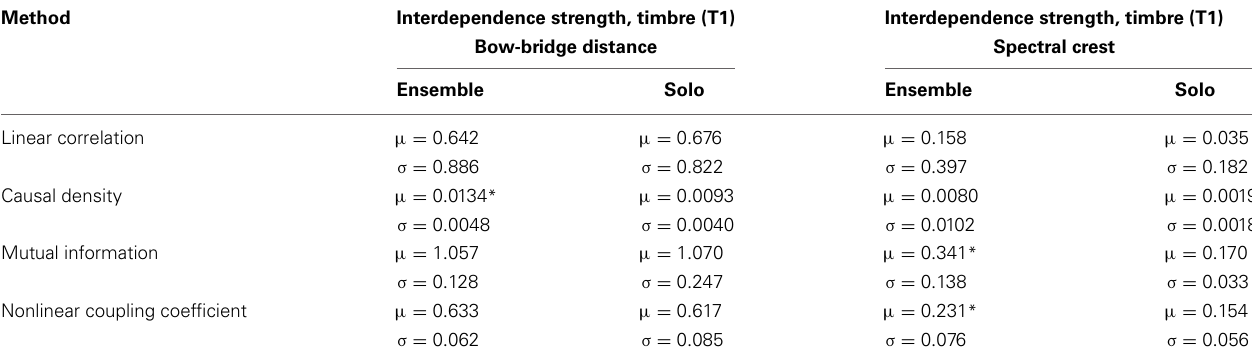
Table 4 | Mean ( μ ) and standard deviation ( σ , N = 7) of interdependence strength for the Timbre dimension, per feature and experimental condition.